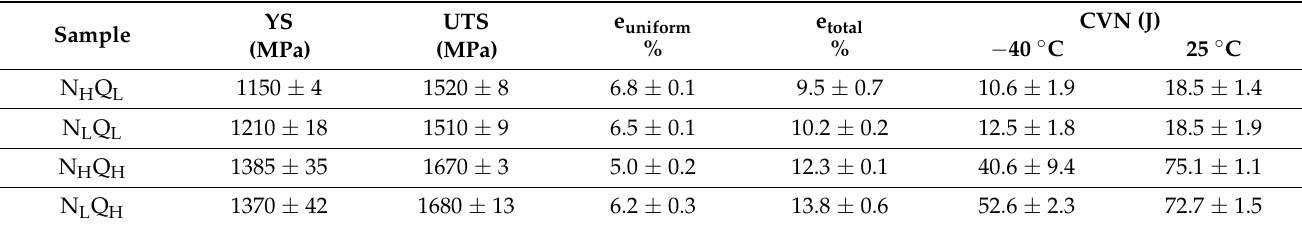
Table 4. Mechanical properties of the alloy after the various heat treatments.